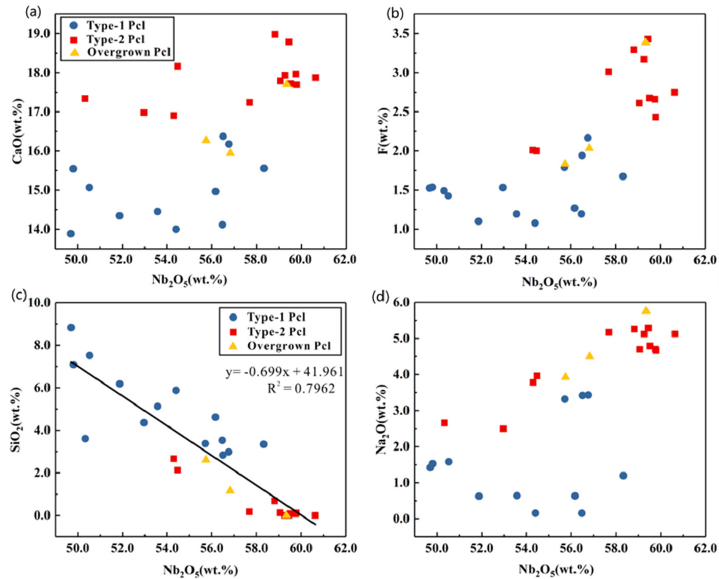
Figure 4. Major element compositions of pyrochlore in the Shuangshan nepheline syenite as a function of the Nb 2 O 5 (wt.%) concentration: ( a ) CaO, ( b ) F, ( c ) SiO 2 , and ( d ) Na 2 O.